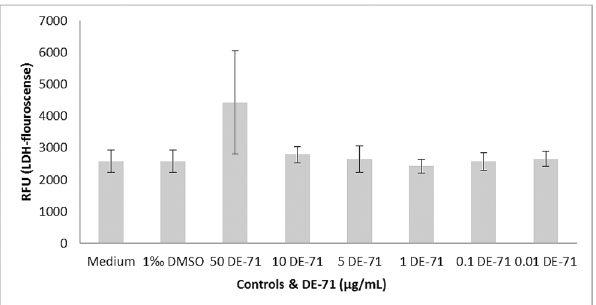
Fig 3. Mean of LDH-fluorescence from DE-71 exposed and LPS-stimulated PBMCs. DE-71 was added in six different concentrations to each culture and medium, and DMSO in medium served as negative controls in duplicate, n = 2 cultures in triplicates. LDH: lactate dehydrogenase, LPS: lipopolysaccharide, DMSO: dimethyl sulfoxid, RFU: relative fluorescence